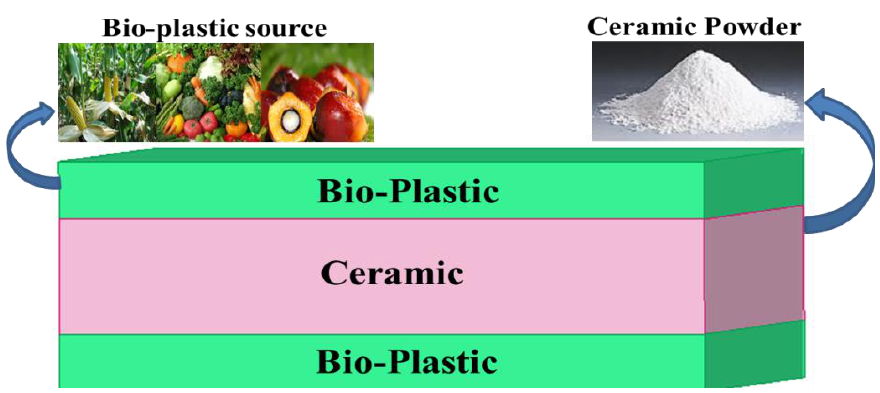
Figure 1. Substrate material structure.